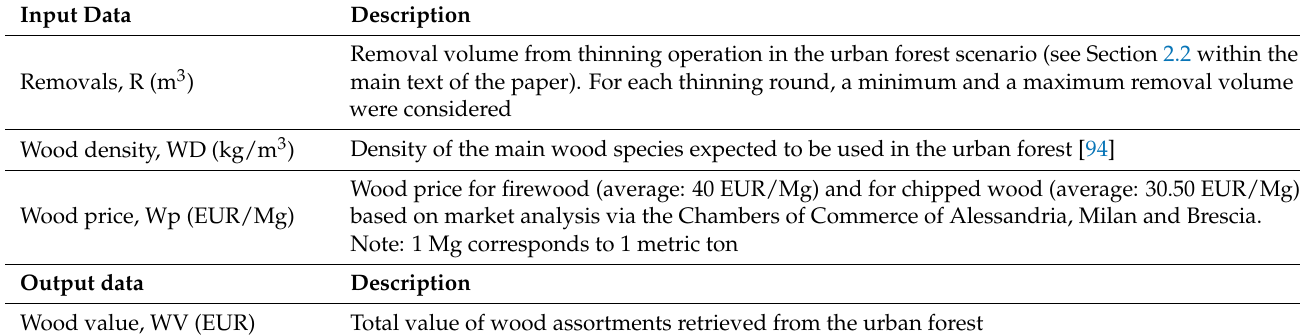
Table 3. Input and output data for the assessment and evaluation of the provision of biomass and